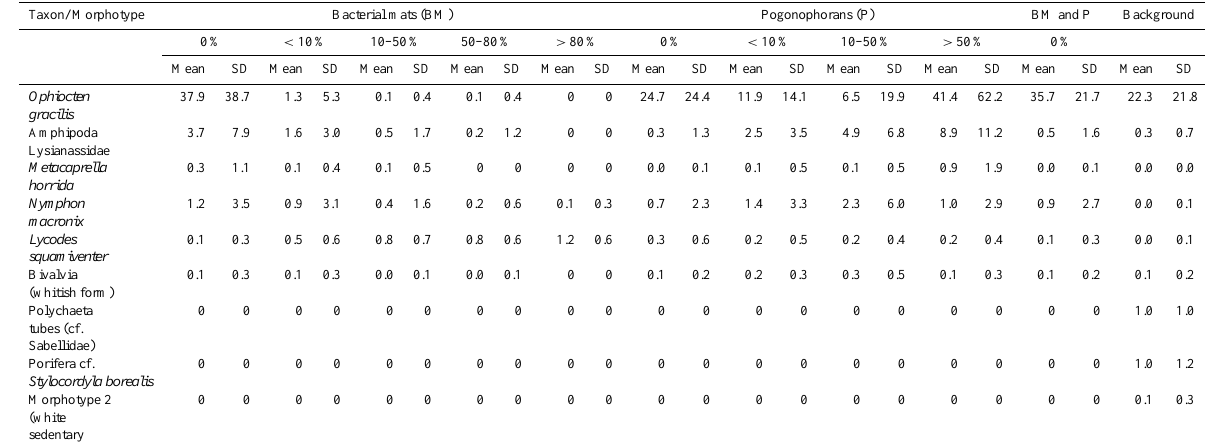
Table 4. Mean density (ind.m 2 ) and standard deviations (SD) of the most abundant taxa in areas of different coverage (%) by bacterial mats and pogonophorans. Data from OFOS transects I, II and III combined and from the background transect